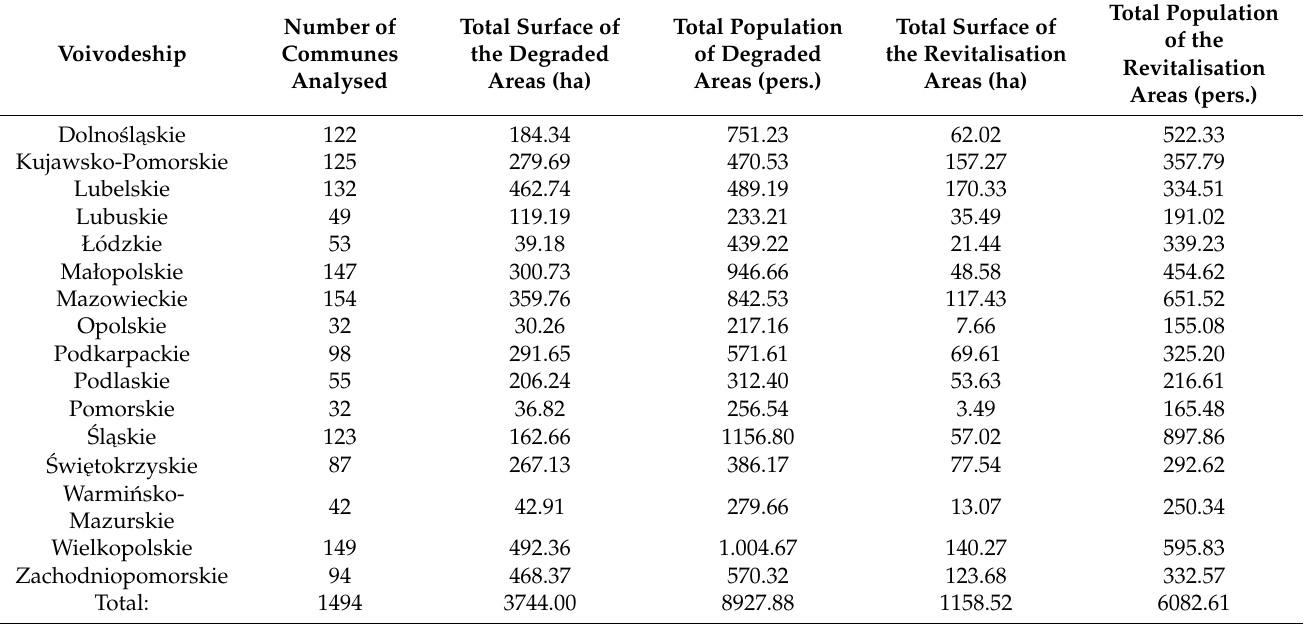
Table 4. Surface and population of the degraded and revitalisation areas in the Voivodeships.